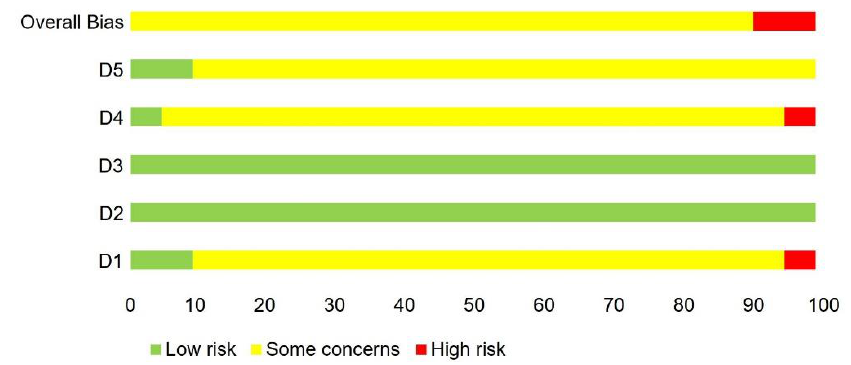
Figure 3. Risk of bias rating within domains Domain 1 to Domain 5 as percentage of all studies. Legend: D1 = Randomization process, D2 = deviations from intended interventions, D3 = missing outcome data, D4 = measurement of the outcome, D5 = selection of the reported